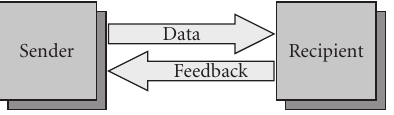
Figure 1: The communication